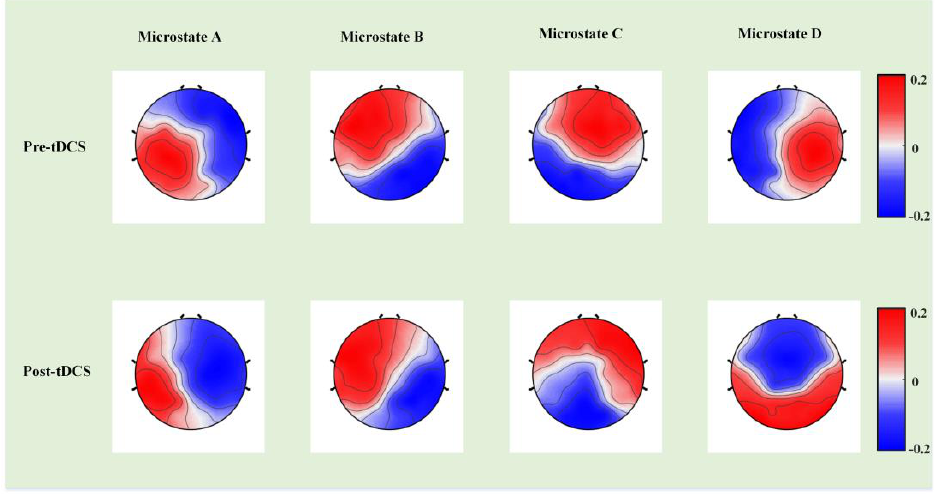
Figure 4. The template maps of the four microstate classes in the experimental group before and after tDCS.